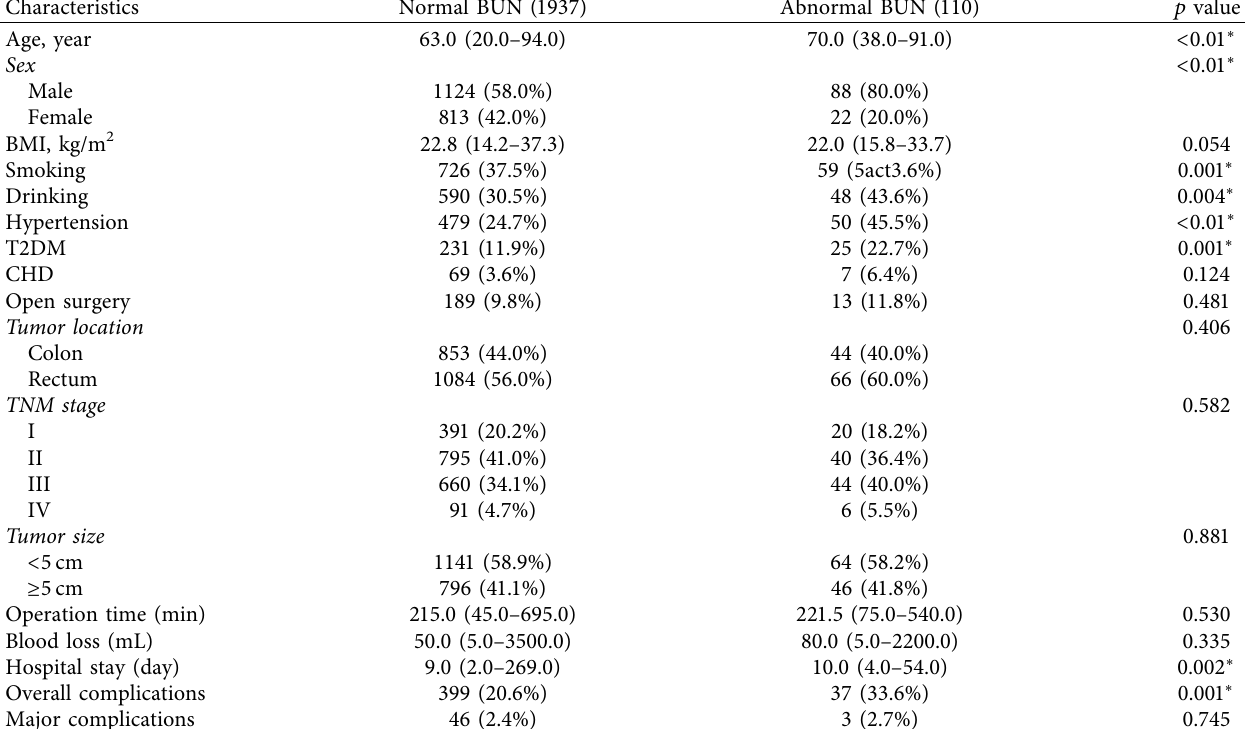
Table 1: Comparison between the normal BUN group and the abnormal BUN group.